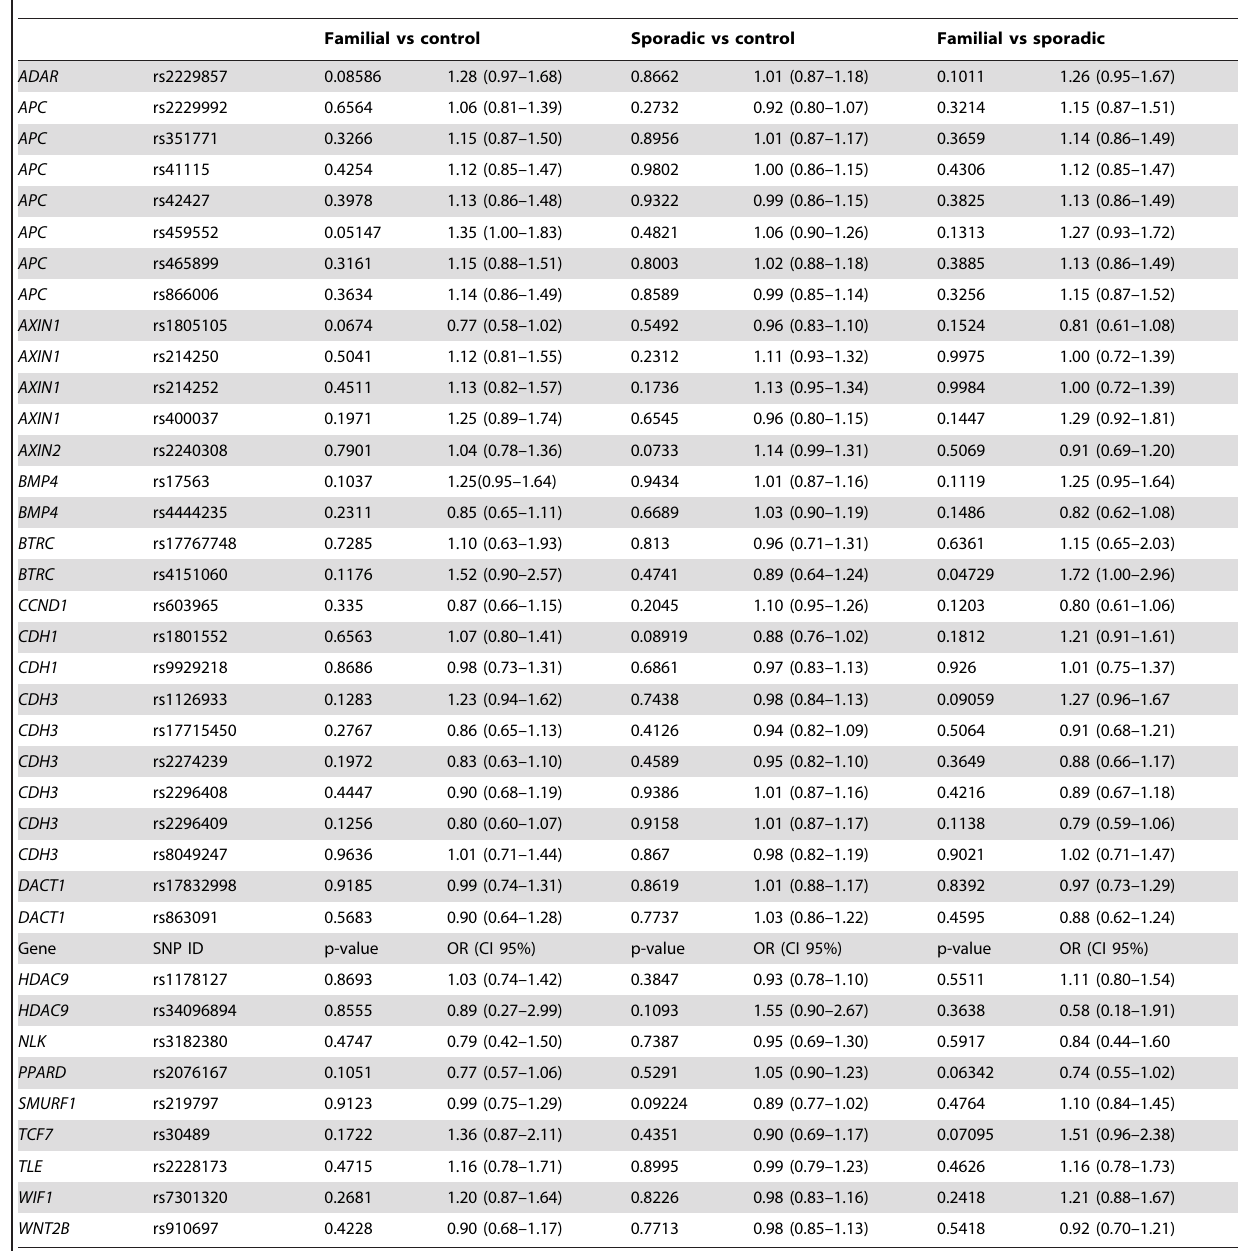
Table 2. Association values for stratified analysis in familial and sporadic CRC groups.